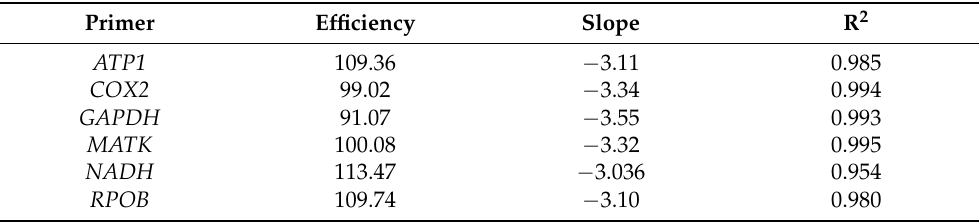
Table 1. Data of efficiency and activity of each set of primers for ATP1, COX2, GAPDH, MATK, NADH and RPOB genes.